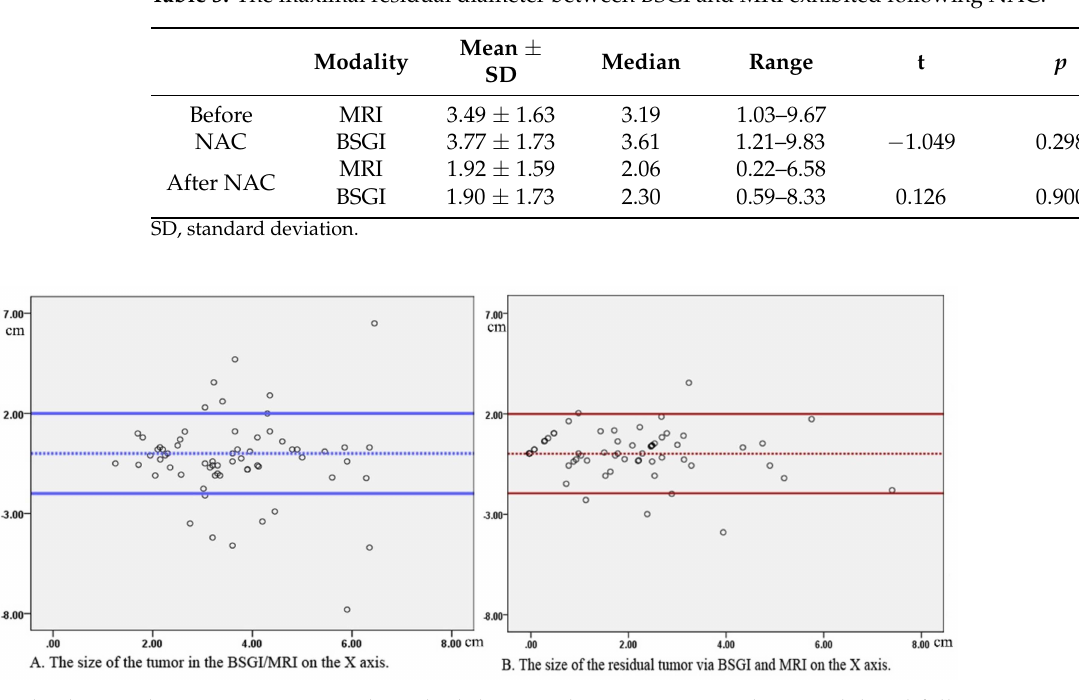
Figure 1. Bland–Altman plots compare maximal residual diameter between BSGI and MRI exhibited following NAC. ( A ) Before NAC. Dashed line indicates the mean difference between two methods, solid lines indicate the limits of the agreements (1.96 standard deviations of the mean difference). ( B ) After NAC. Dashed line indicates the mean difference between two methods, solid lines indicate the limits of the agreements (1.96 standard deviations of the mean